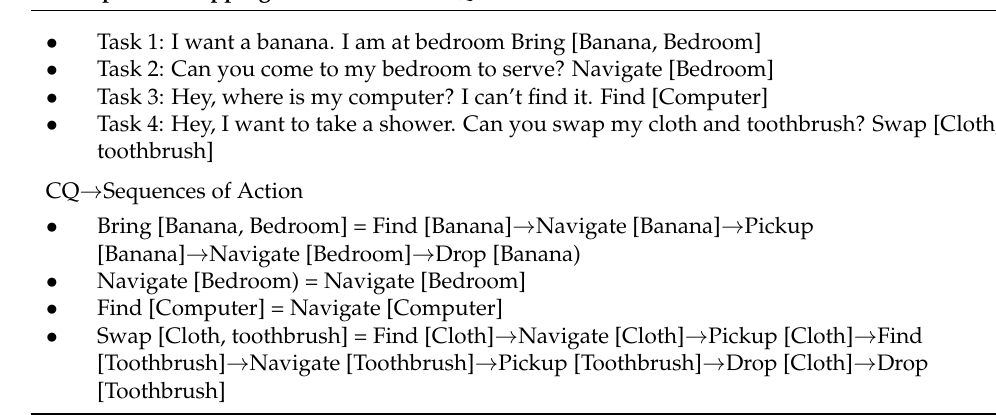
Table 2. Examples of NLP -> CQ -> Tasks. Examples of Mapping between NLP →